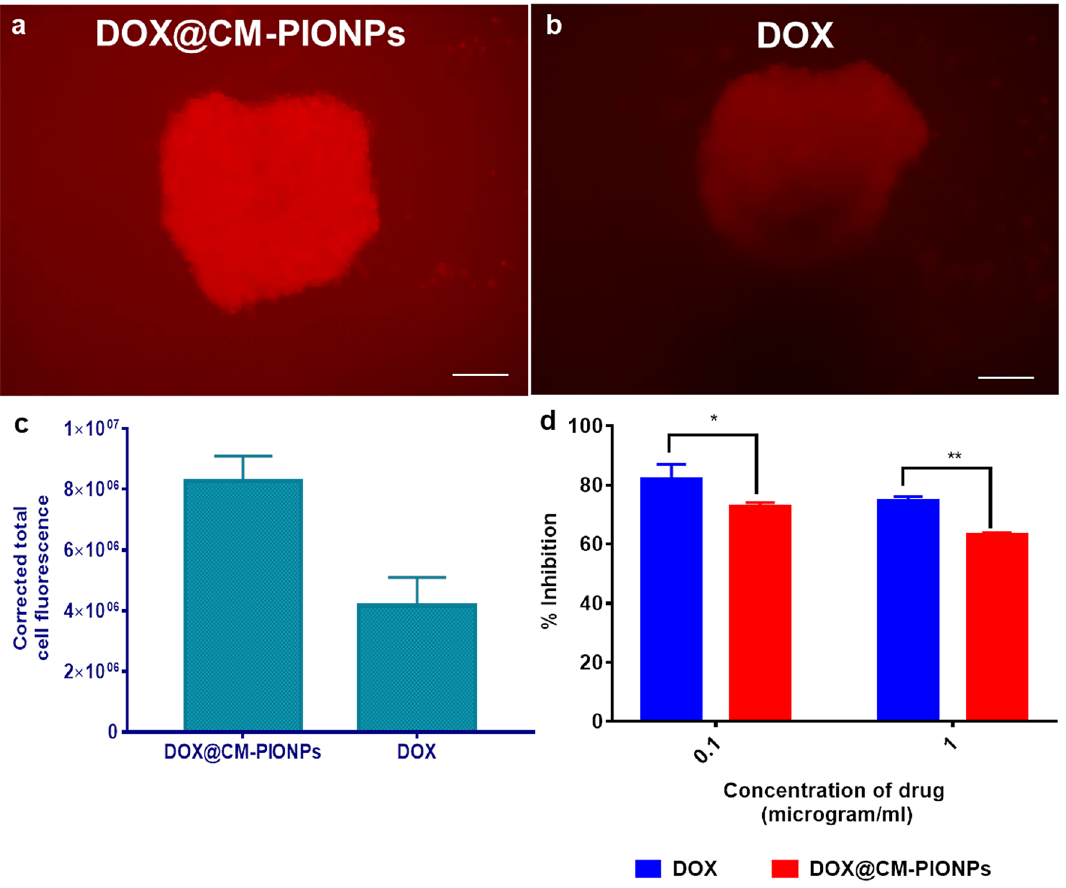
Figure 4. Tumoroid penetration study in GB-spheroids. Fluorescent microscopic images of representative GB-spheroids treated with ( a ) DOX@CM-PIONPs and ( b ) DOX. ( c ) Quantitative analysis of penetration potential. Total cell fluorescence of cells treated with DOX@CM-PIONPs were found to be significantly higher compared to DOX; ( d ) Cell viability analysis in GB-spheroids treated with DOX and DOX@CM-PIONPs. The results clearly show the effect of DOX@CM-PIONPs towards spheroids, where the free drug showed only less potency in reducing cell viability. The experiments were carried out in triplicates and error bars denote standard